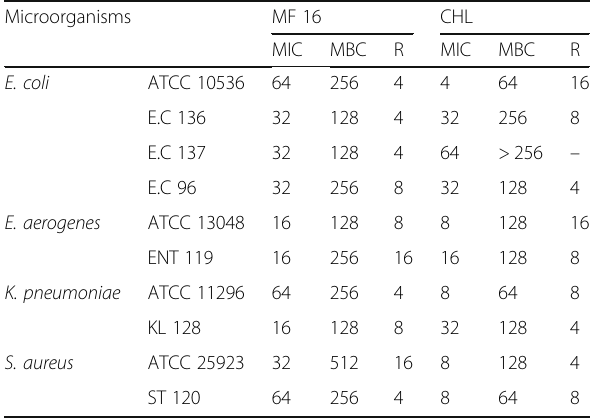
Table 5 Minimum Inhibitory Concentrations (MIC), Minimum Bactericidal Concentrations (MBC) and MBC/MIC ratios (R) of palmitin (MF16) ( μ